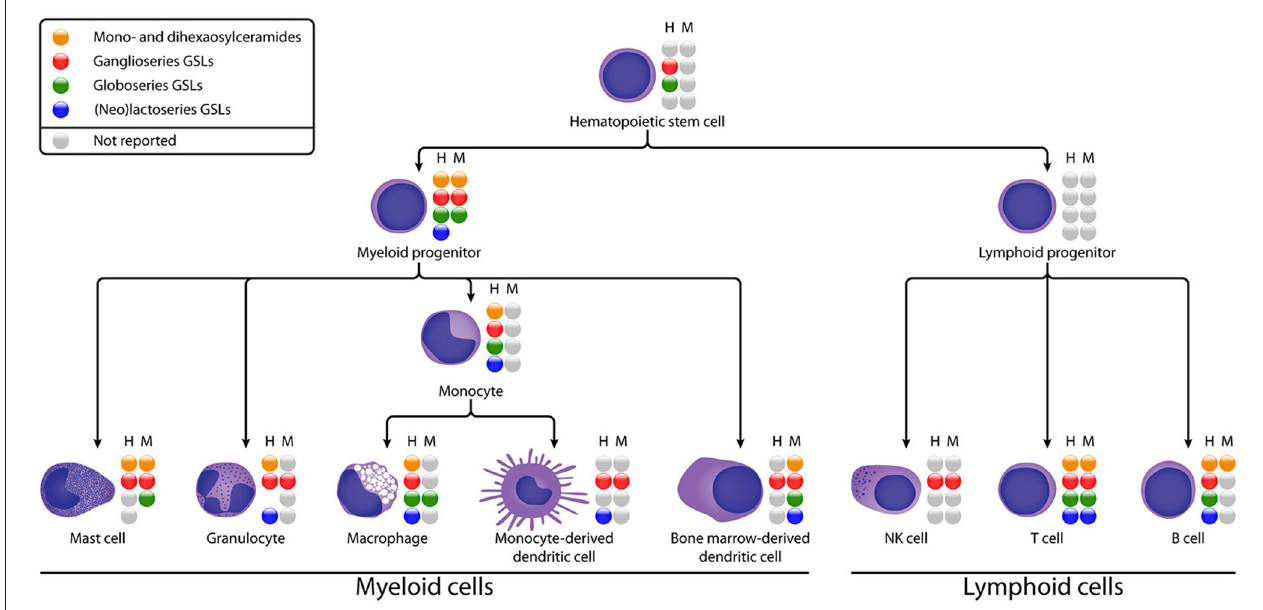
FIGURE 2 | Schematic diagram of GSL expression in different stages of human (H) and murine (M) immune cell differentiation. GSL subsets that have been reported are represented by colored spheres, unreported subsets are represented by gray spheres. The absence of a sphere indicates that the GSL subset could not be detected. See Table 1 for details on the subset